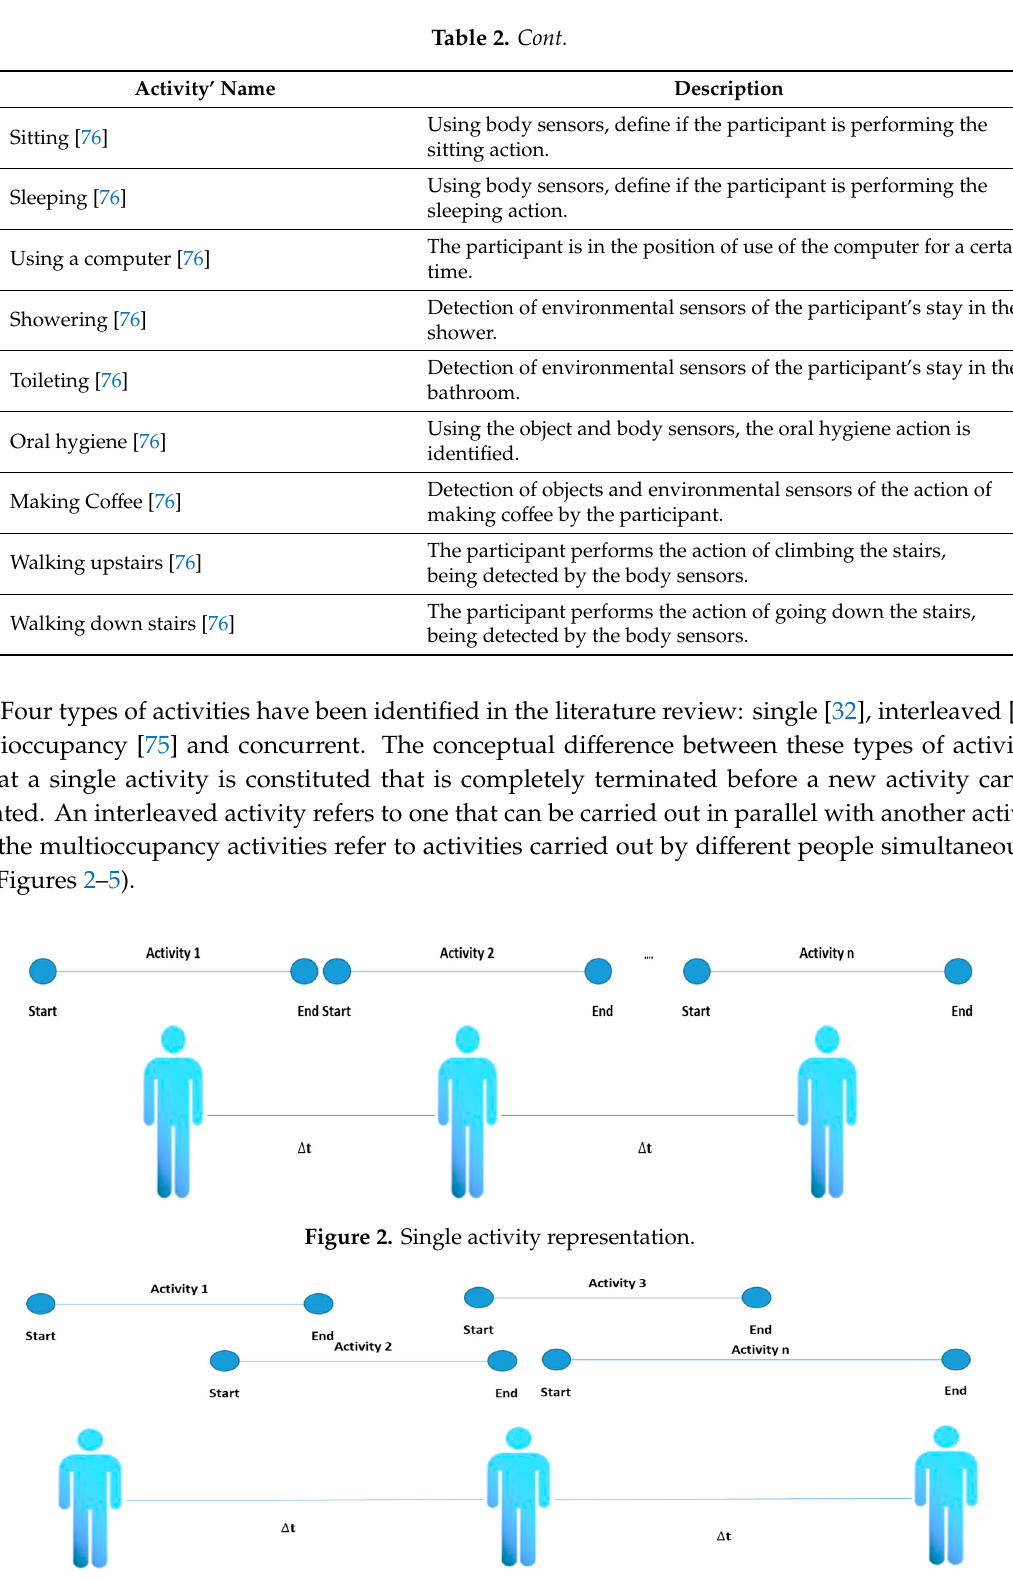
Figure 3. Interleaved activity representation.